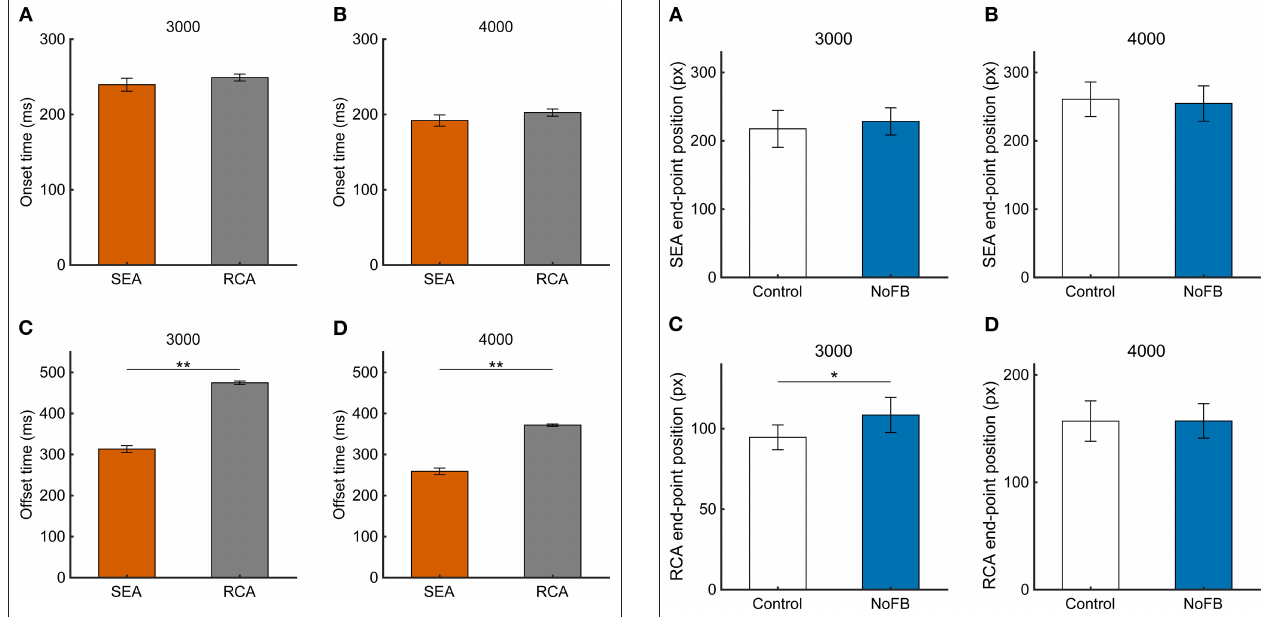
FIGURE 8 | The end-point positions of (A,B) SEA and (C,D) RCA at target speeds of 3,000 and 4,000 pixels/s in Experiment 2. White and blue bars show control and NoFB conditions, respectively. Error bars are SEM. * p <